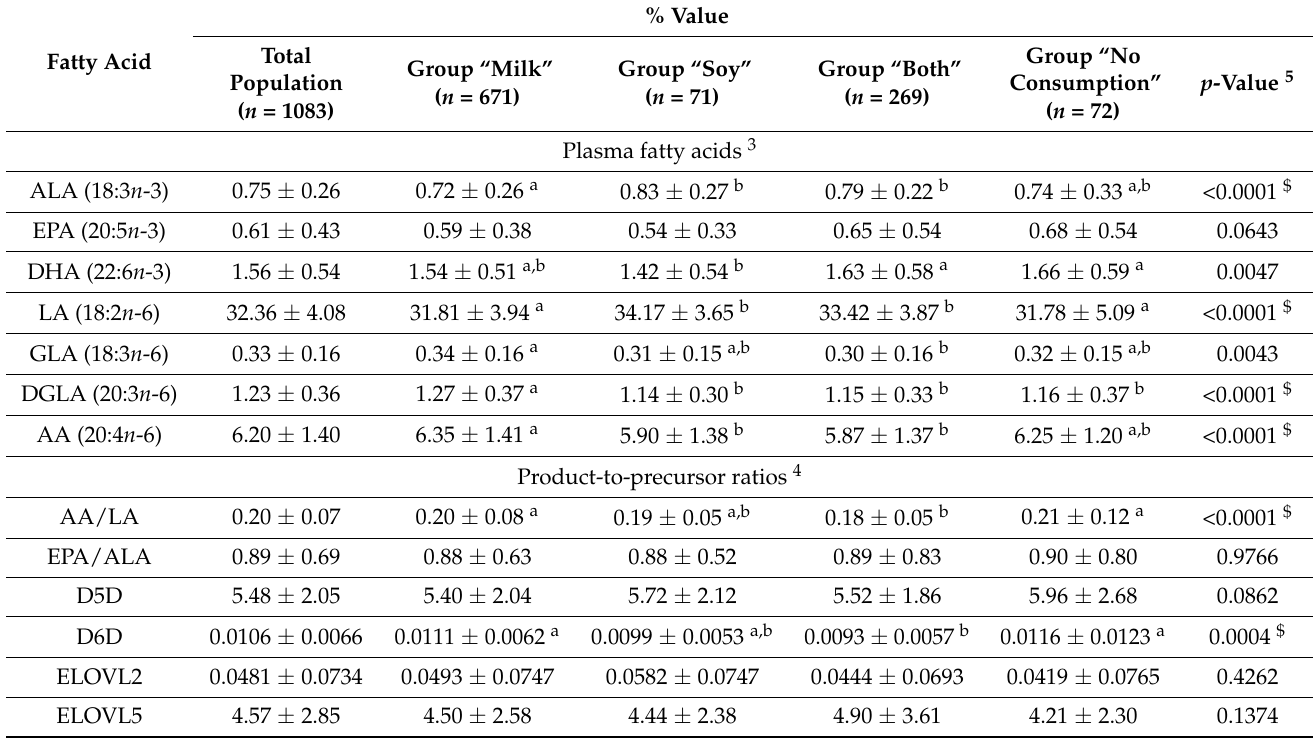
Table 2. Plasma polyunsaturated fatty acid levels and ratios by beverage intake subgroups 1,2